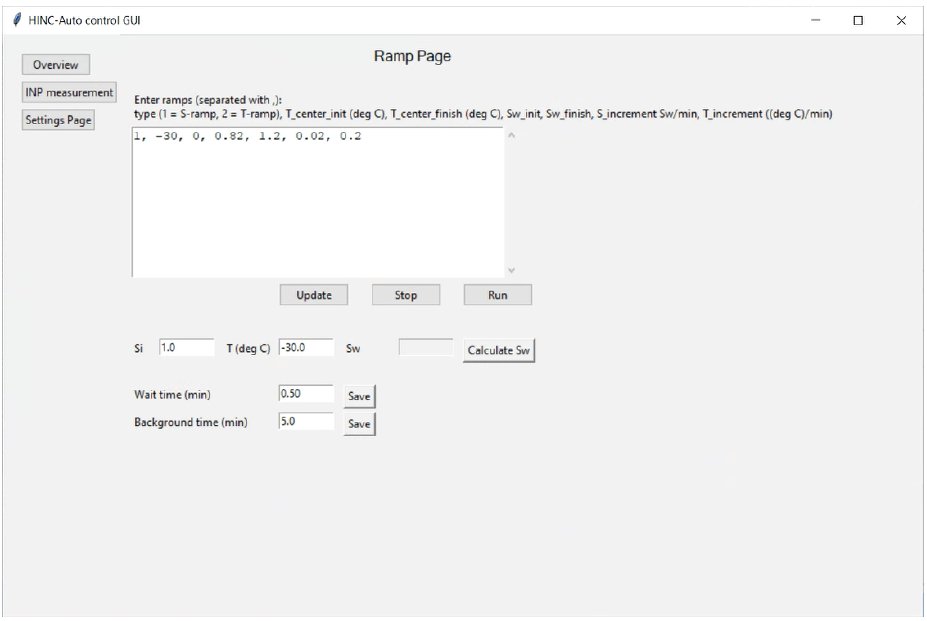
Figure A9. Window of the guided user interface used to control RH or T ramps with HINC-Auto.